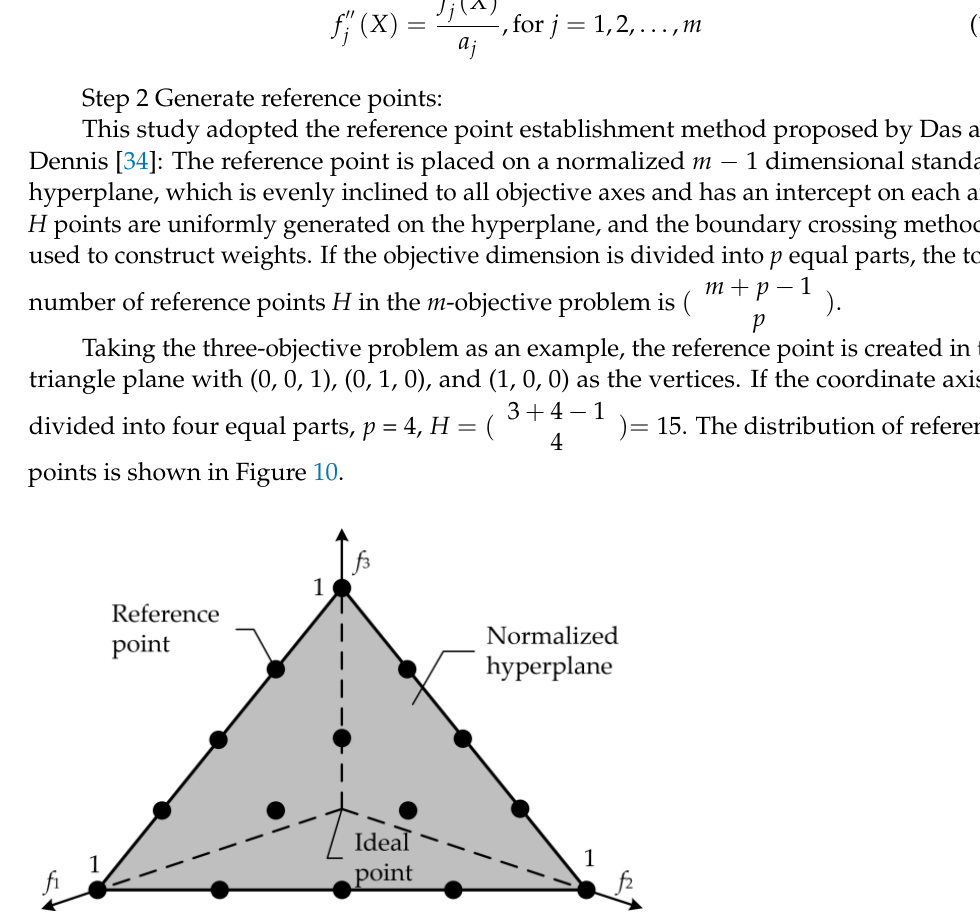
Figure 10. Reference point distribution of the standard hyperplane for the t hree-objective optimi- zation